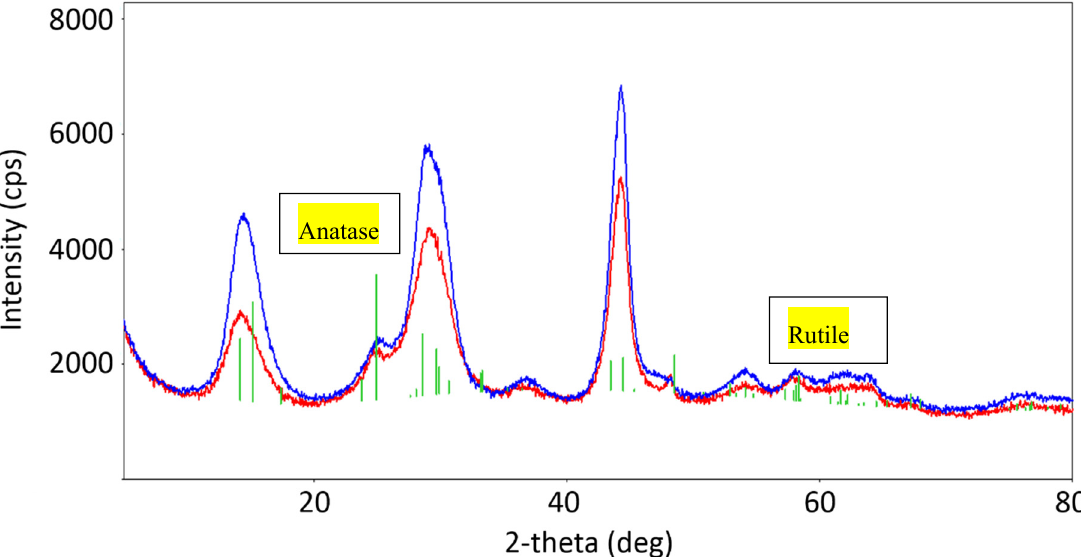
Figure 1. XRD patterns of pristine TiO 2 (red) and pyrolytic carbon/TiO 2 nanocomposite (p-C/TiO 2 ) (blue) specimens. The green lines refer to the diffraction peaks of titania available in the instrument’s database.